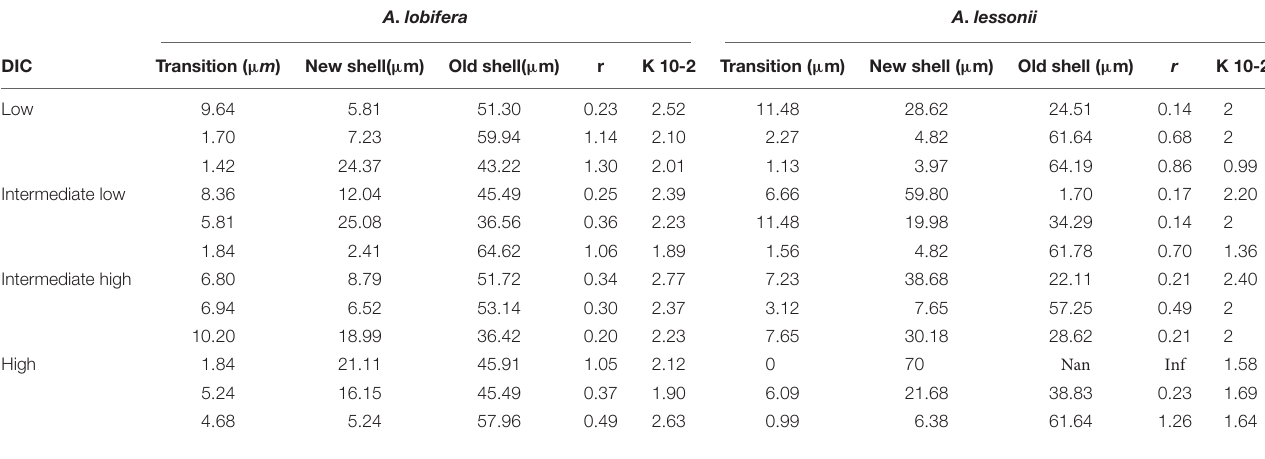
TABLE 3 | Logistic equation coefficients for the uptake of 135 Ba into the skeleton of A. lobifera and A. lessonii . A .